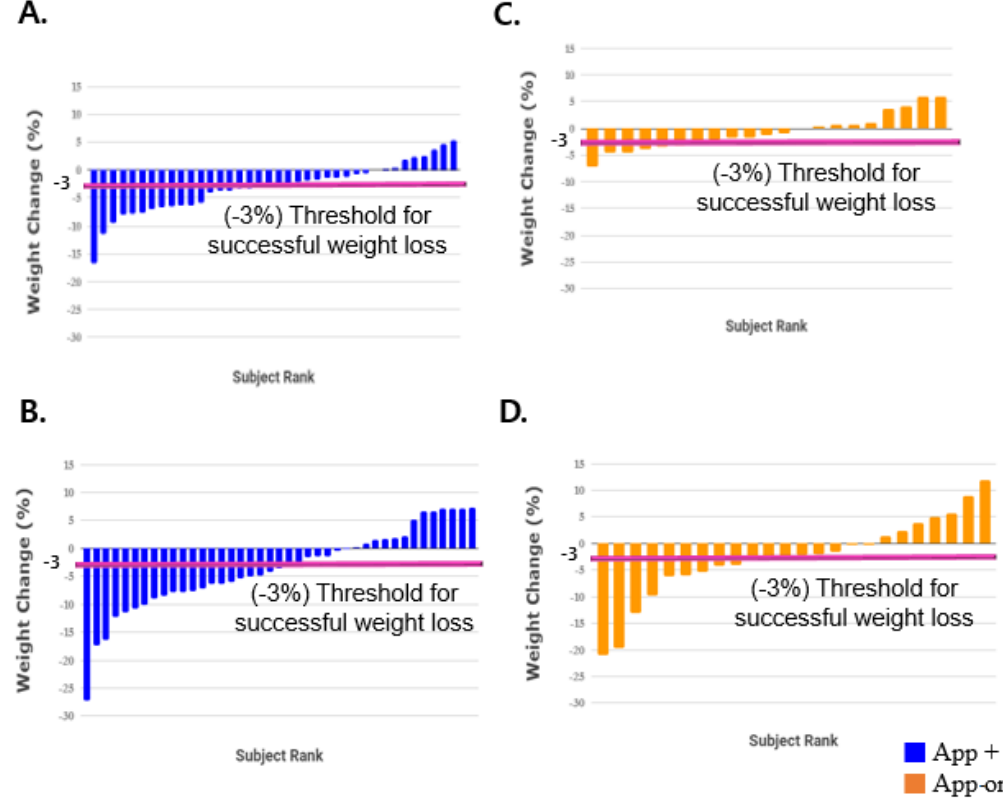
Figure 5. Weight change based on individual data from the experimental group at the 8-week follow-up (A), from the experimental group at the 24-week follow-up (B), from the control group at the 8-week follow-up (C), and from the control group at the 24-week follow-up (D). CBT: cognitive behavioral